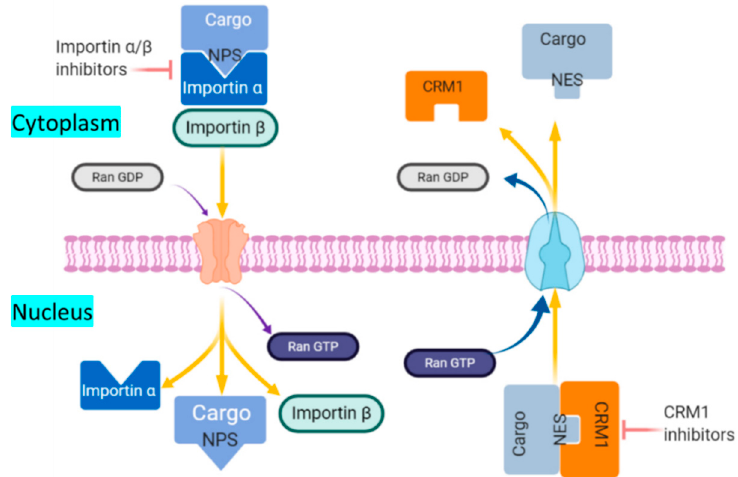
Figure 3. p65 shuttling and the current therapeutic targets explored in the pathway. After ubiquitination IkB, translocation of p65/p50 (Cargo) happens via arginine and lysine-rich NLS (Nuclear localization signals) of p65 interaction with importin α / β heterodimer. This trimeric protein complex (cNLS/importin α / β protein) ferrying into the nucleus is facilitated through importin β interaction with nuclear pore complexes (NPCs). Whereas export of p65 via the CRM1-dependent